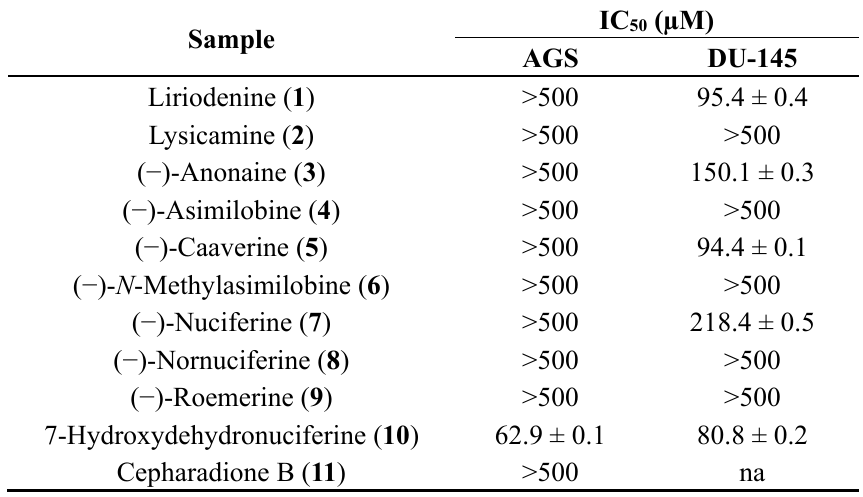
Table 2. Anti-proliferative effects of aporphine alkaloids on AGS and DU-145 cells. Sample